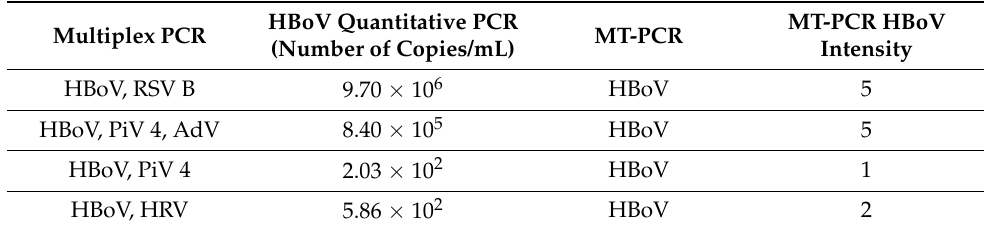
Table 1. Samples in which only HBoV was detected on MT-PCR with the results of two other tests for those samples.